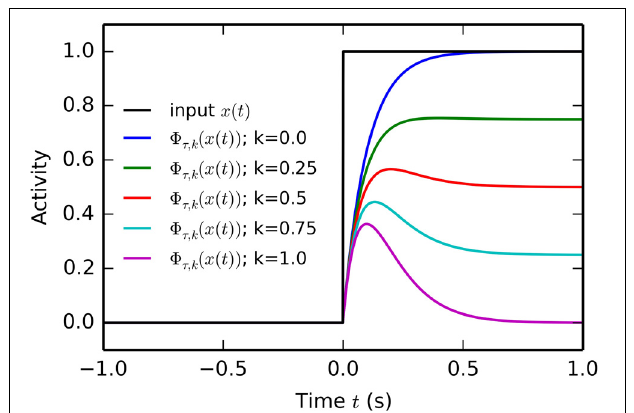
FIGURE 2 | Temporal profile of the phasic function (cid:2) τ , k ( x ) defined by Equation (5). At t = 0, the Heaviside input x ( t ) goes from 0 to 1. The temporal profile of five phasic functions (cid:2) τ , k ( x ) with τ = 50ms and k ranging from 0 to 1 is displayed. If k = 0, the phasifunction is a simple leaky integrator with time constant τ . If k = 1, the output of the filter is a localized bump peaking at t = τ and converging toward 0.